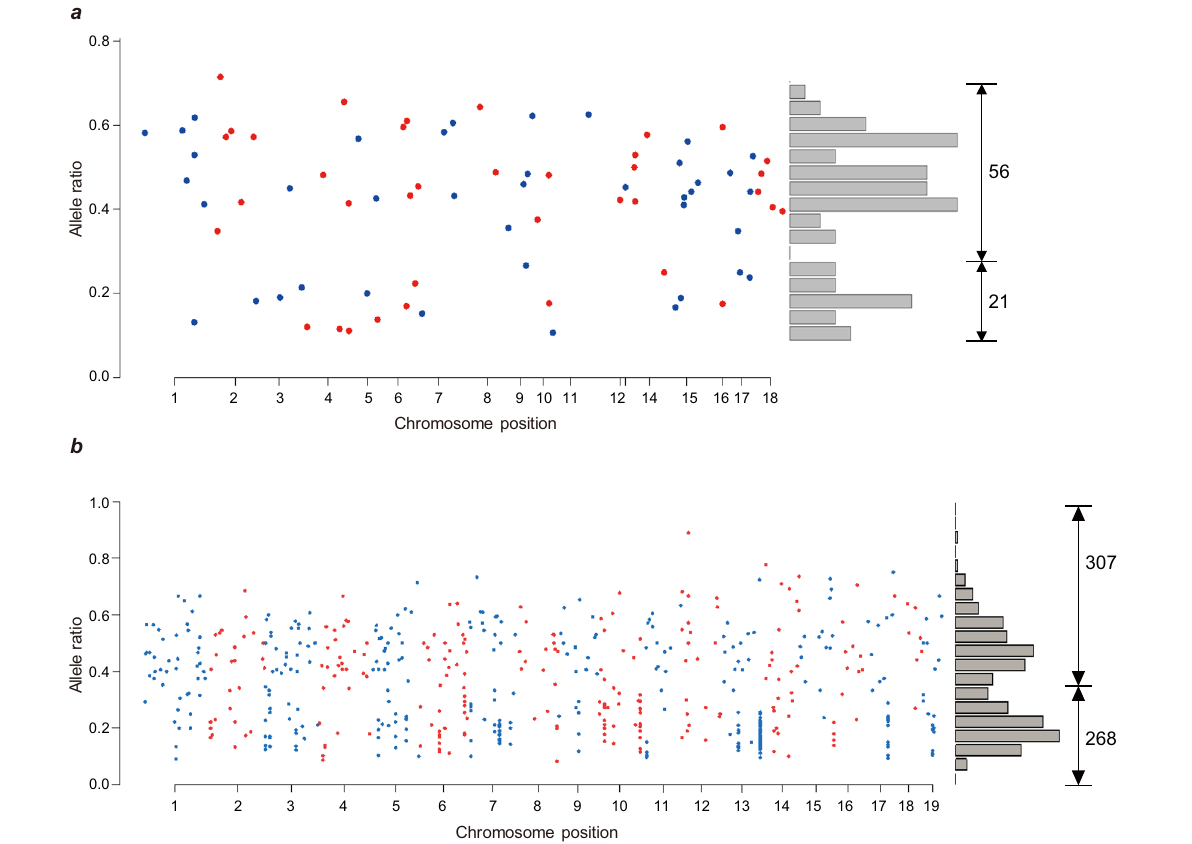
Fig. 5 The allele ratio of DNMs detected in F1s and F2s of the B-3 sibship. a DNMs of F1 mice are ordered by their positions on genome, with alternative colors for different chromosomes. Among them, 56 SNVs associate with allele ratio close to 0.5 (2:2), the other 21 SNVs with ratio close to 0.25 (1:3). b DNMs observed in F2 embryos, among which 307 SNVs associate with an allele ratio close to 0.5 (2:2), the other 268 SNVs with ratio close to 0.25